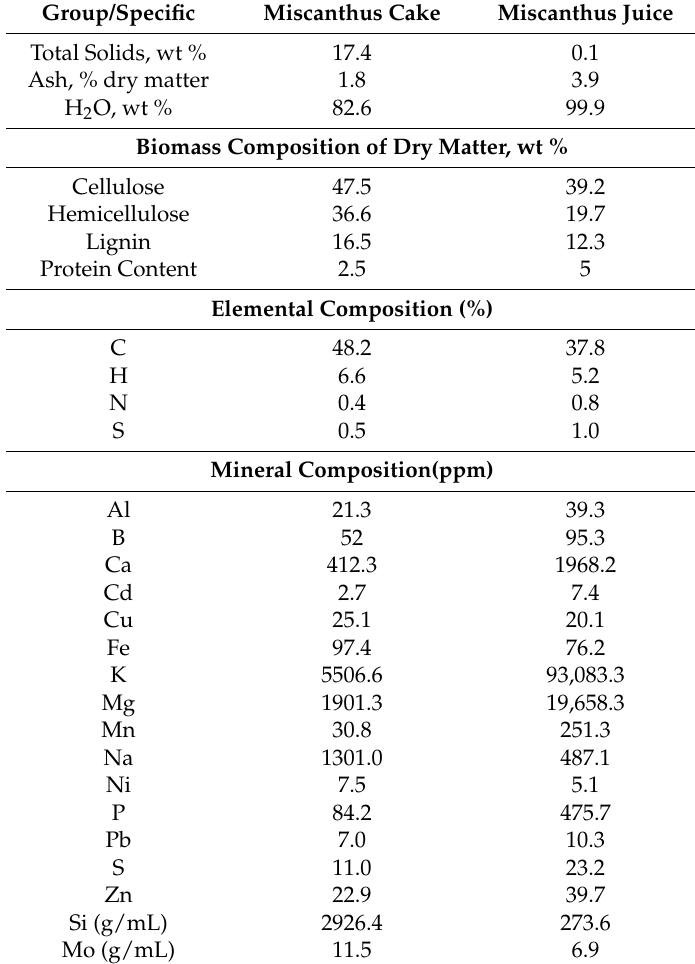
Table 1. Characteristics of MxG cake and juice.